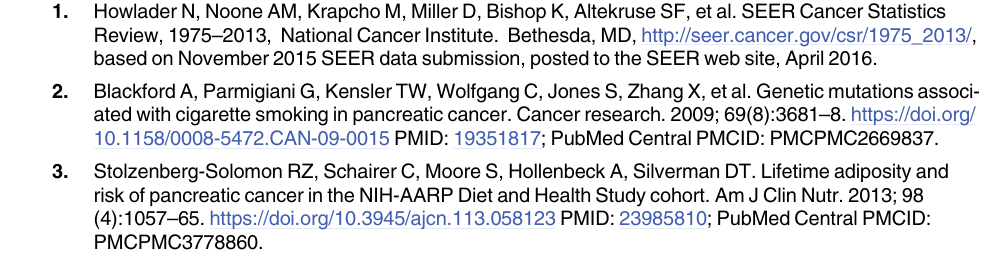
S6 Table. Associations of tryptophan and kynurenines with pancreatic cancer risk among individuals stratified by PLP deficiency status in both the Shanghai and Singapore cohorts